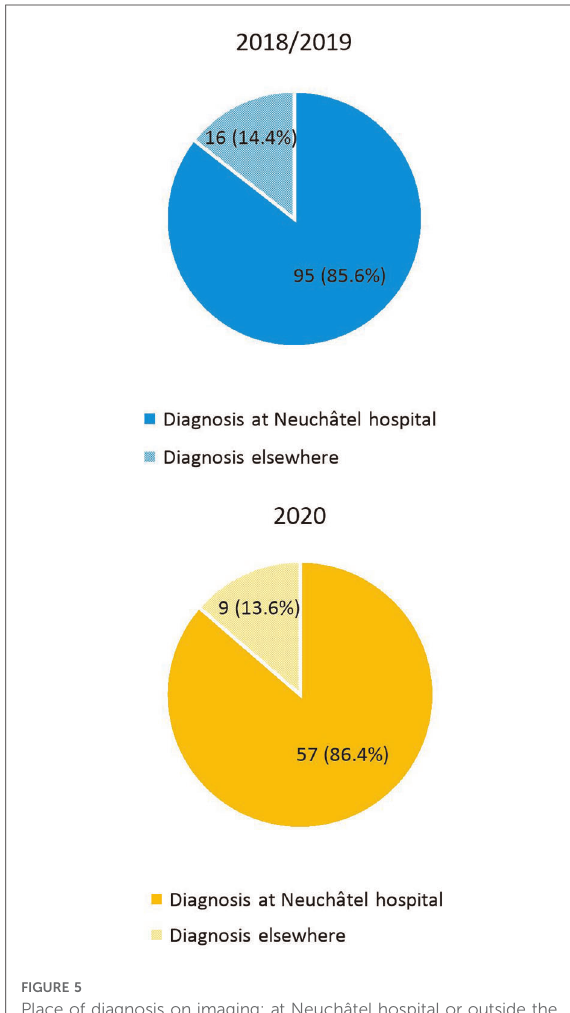
FIGURE 5 Place of diagnosis on imaging: at Neuchâtel hospital or outside the hospital (general practitioner, medical center) in 2018/2019 and